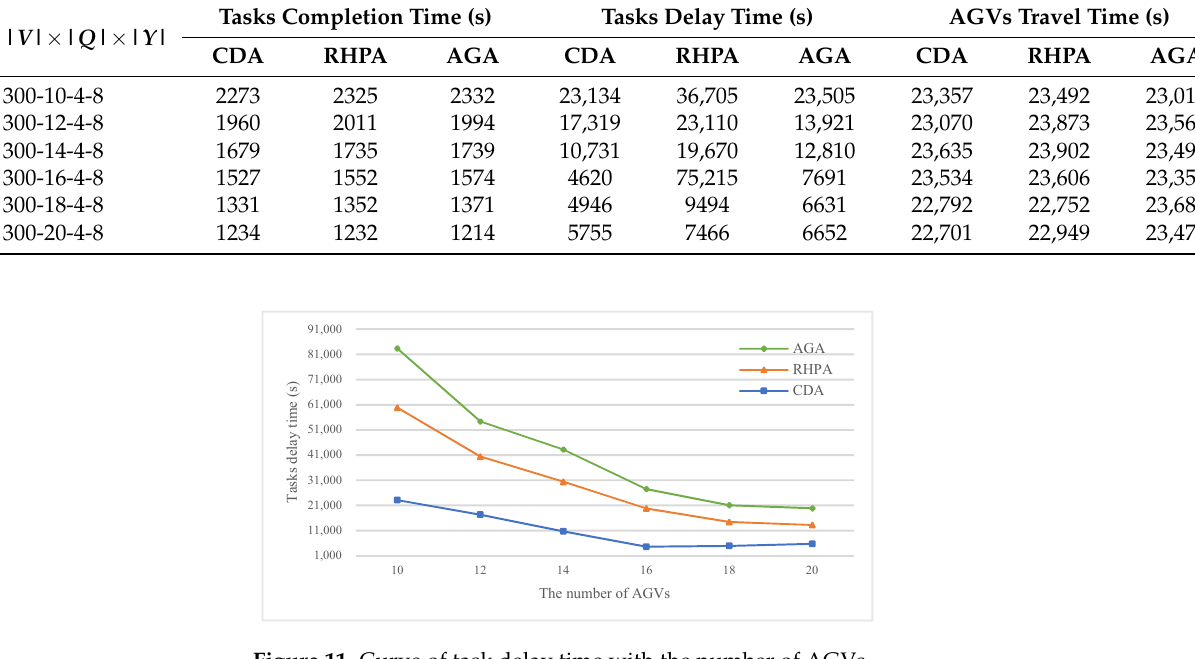
Table 9. Scheduling results of three algorithms with different number of AGVs.